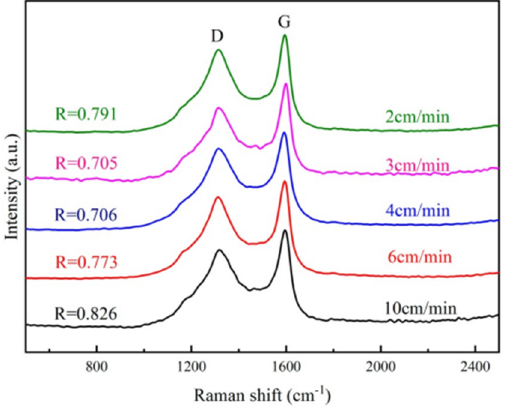
Figure 4. Raman spectra of CNTs/CF multiscale reinforcements prepared at different moving speeds. The flow rate of H 2 and C 2 H 2 was 0.3 L/min.